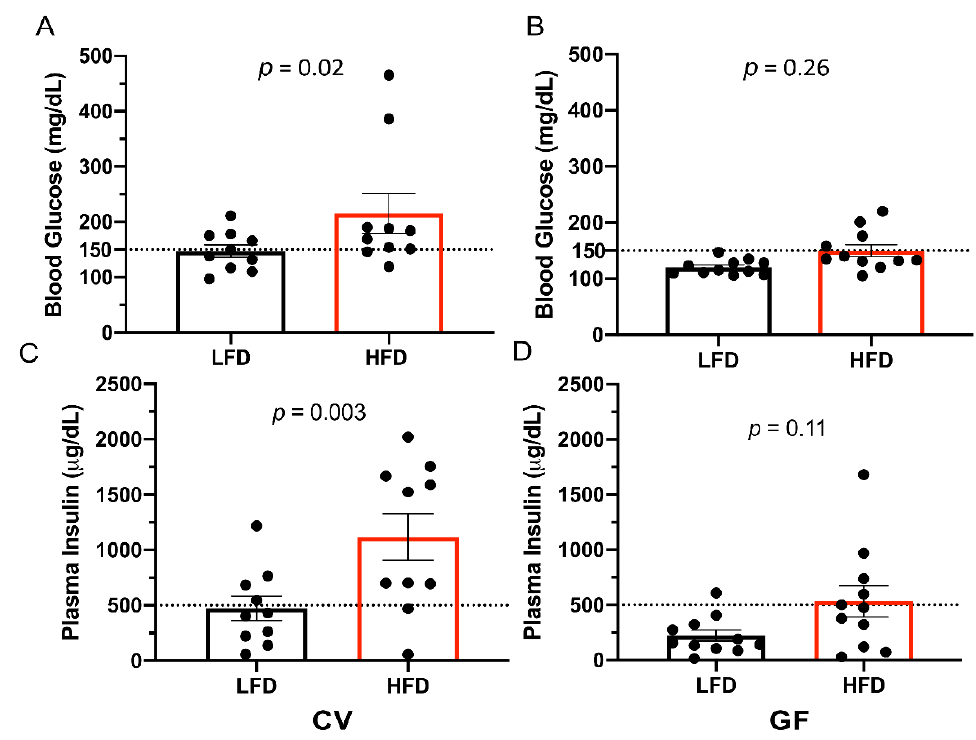
Figure 3. The HFD increases blood glucose and plasma insulin levels in only CV male Tac:SW mice. Quantification of blood glucose concentrations (panels A , B ) and plasma insulin concentrations (panels C , D ) in CV ( n = 10) and GF ( n = 11) mice on the LFD control or the HFD. The values for individual mice are shown as dots, the means as bars, and horizontal lines indicate the standard error of the mean ( ± SEM). The dotted horizontal lines indicate elevated concentrations. Abbreviations: CV, conventional; GF, germ-free; HFD, high fat diet; LFD, low fat diet; Tac:SW, Taconic Swiss Webster. Table 4. Effect of the low- and high-fat diets on glucose metabolism in conventional and germ-free male Tac:SW mice. Conventional Germ-Free p -values LFD